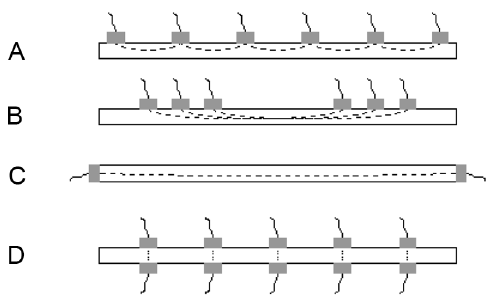
Fig. 1. Diagrams showing each of the measurement methods applied with an ultrasound device: A) five times with a spacing of 200 mm on the tangential surface at early wood positions using the indirect method; B) Three times with a spacing of 600 mm on the tangential surface at early wood positions using the indirect method; C) once between the end surfaces in the longitudinal direction; D) five times in the radial direction by random selection in the direct